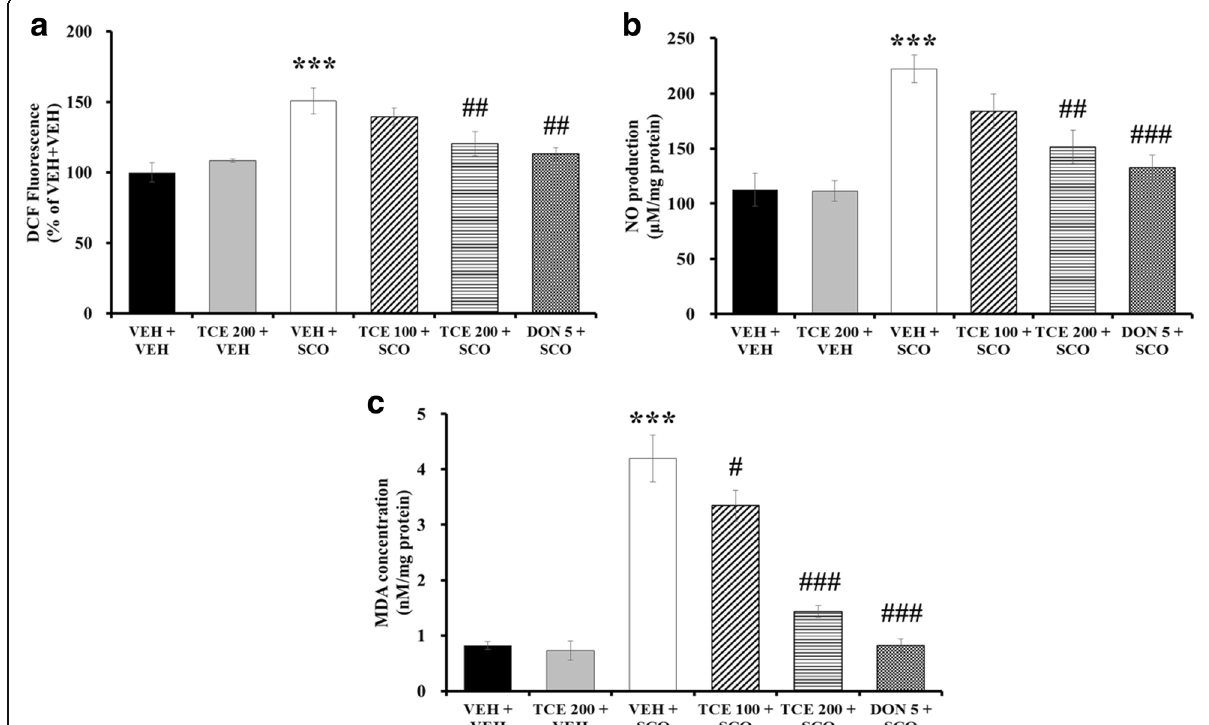
Fig. 5 Effect of TCE on oxidative damage induced by scopolamine in the hippocampus of mice. a DCF fluorescence in the hippocampus was determined to assess effect of TCE on ROS production ( n = 3 per group). Bar graph is expressed as the percentage of VEH + VEH control. b NO levels in the hippocampus are shown ( n = 3 per group). c MDA concentration in the hippocampus is determined to assess the effect of TCE on lipid peroxidation ( n = 3 per group). The data are expressed as the means ± S.E.M. *** p < 0.001 compared with VEH + VEH; # p < 0.05, ## p < 0.01, ### p < 0.001 compared with VEH + SCO. VEH; vehicle, SCO; scopolamine, DON;